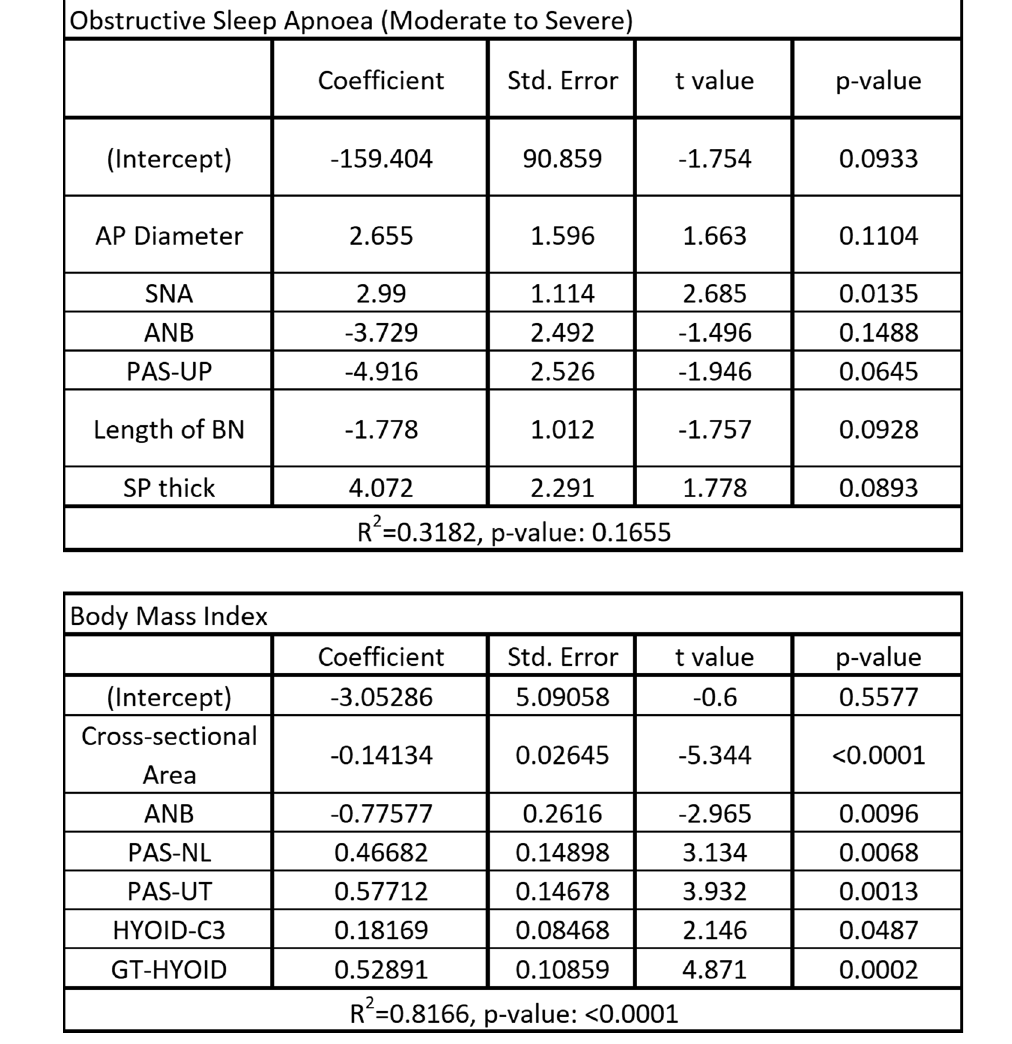
(Table III). Using backwards selection and a variable selection cut-off of p -value < 0.05, none of the variables was noted as a significant predictor of AHI.